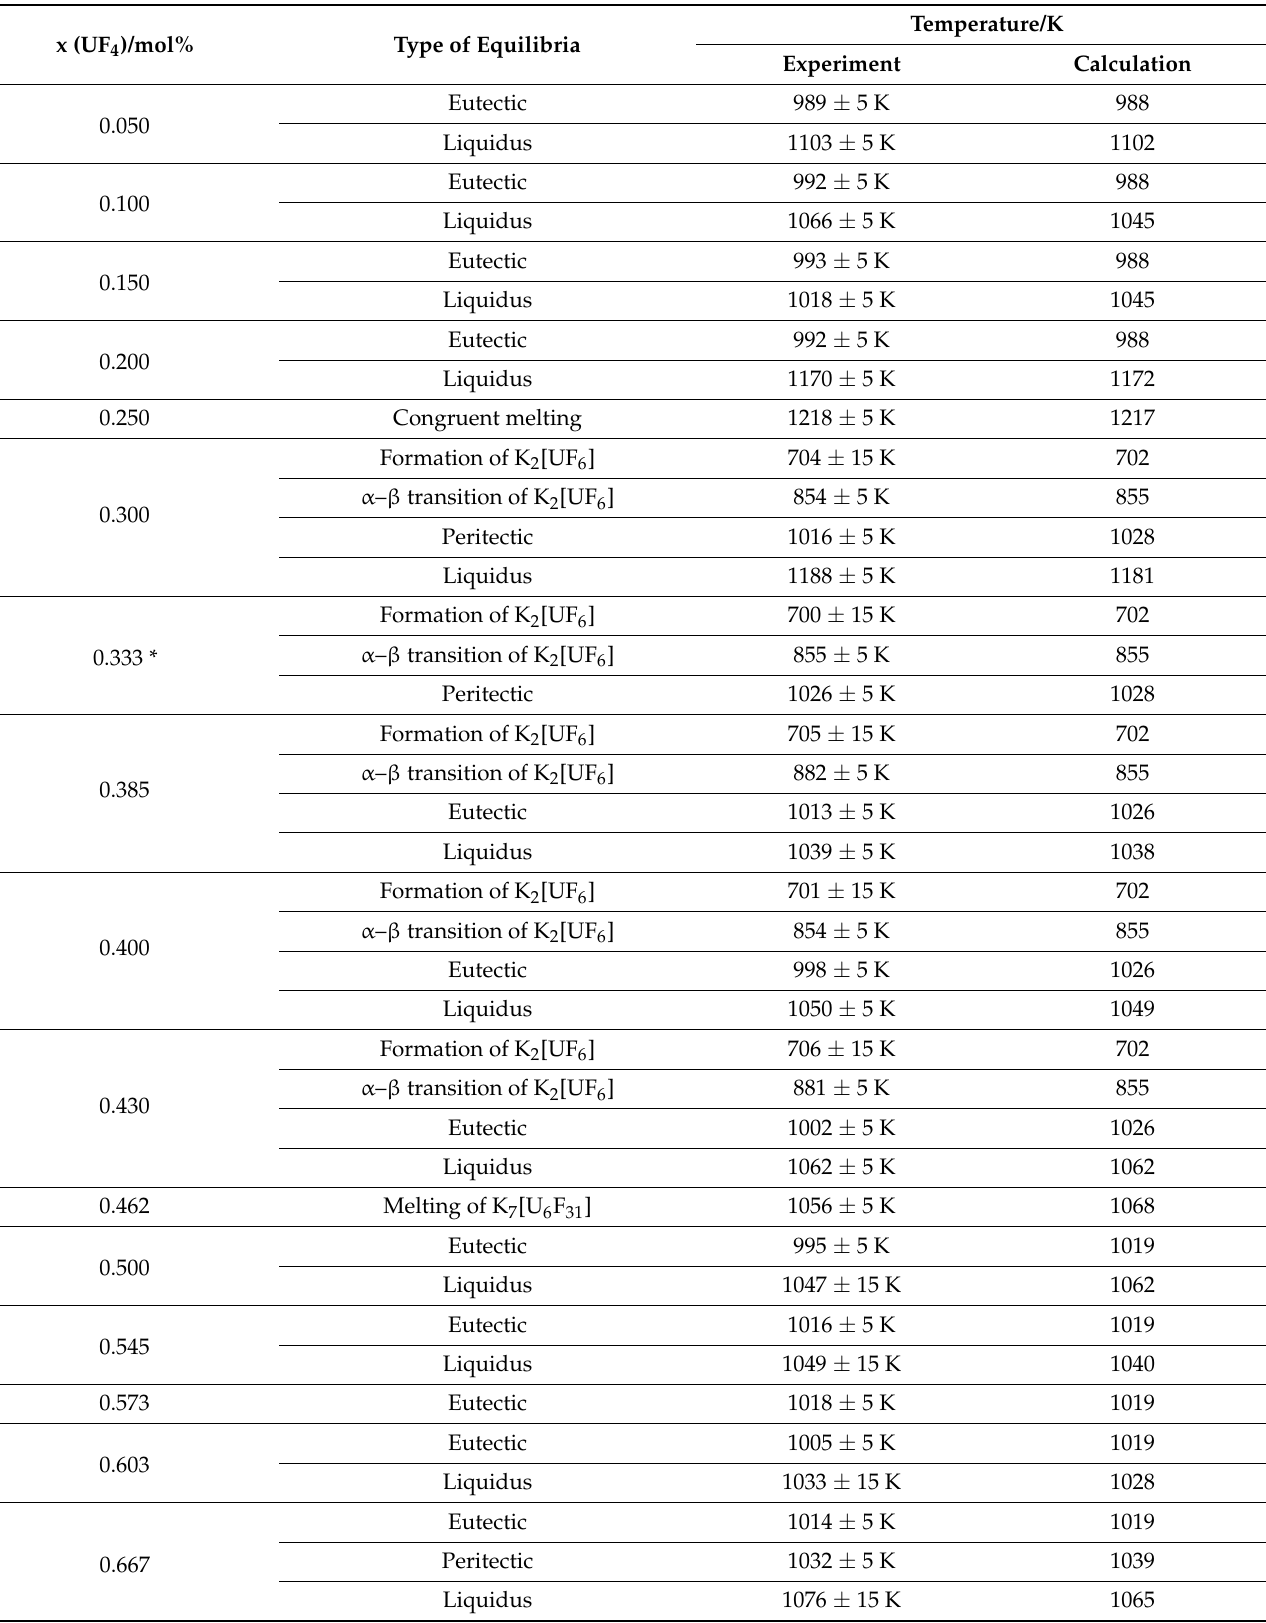
Table 4. Experimental phase equilibria and temperatures obtained by DSC in the KF-UF 4 system and the calculated transition temperatures at these compositions for